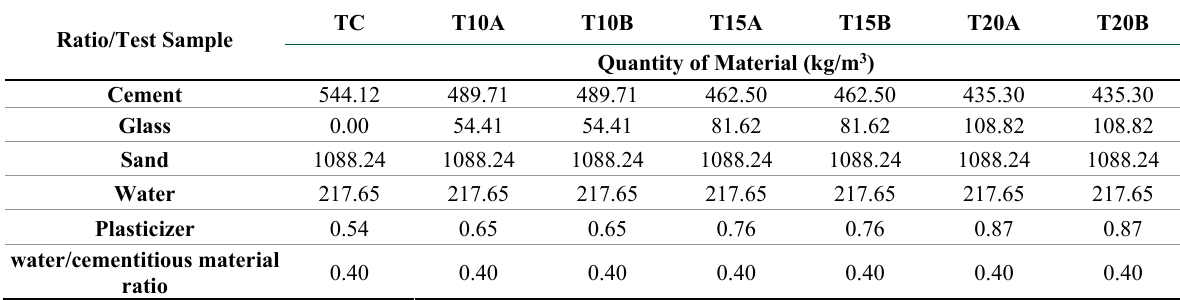
Table 3. Mixing ratios of samples